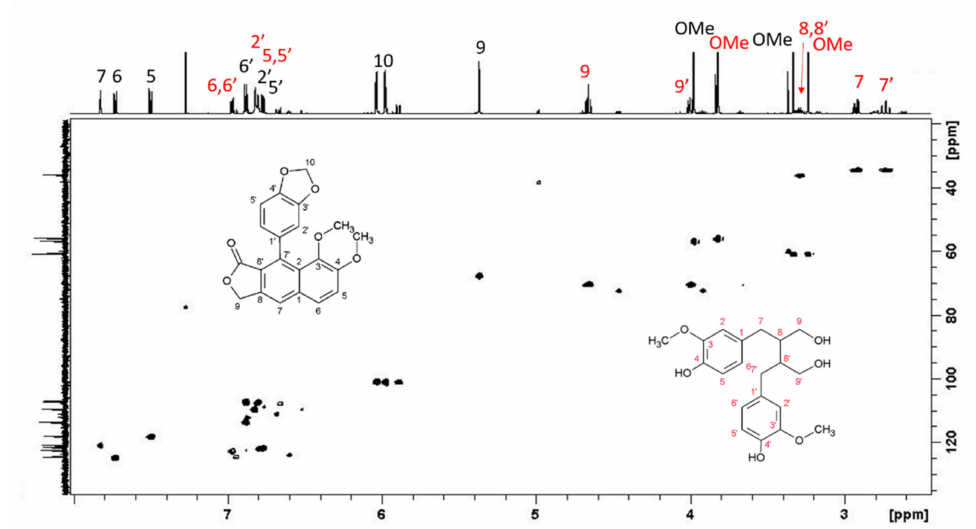
Figure 4. 1 H-NMR spectra recorded at 600MHz extracts from L. mucronatum cell cultures containing isojusticidin and secoisolariciresinol in CDCl 3 solution. Resonance assignment is reported for both compounds (black isojusticin, red secoisolariciresinol. Another unknown compound is present in a much smaller amount and is not yet